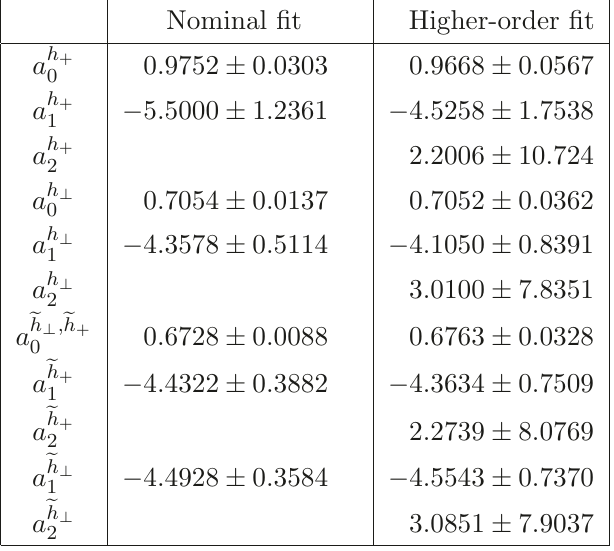
Λ c tensor form factors in the → Λ c form factors are provided as supplemental →